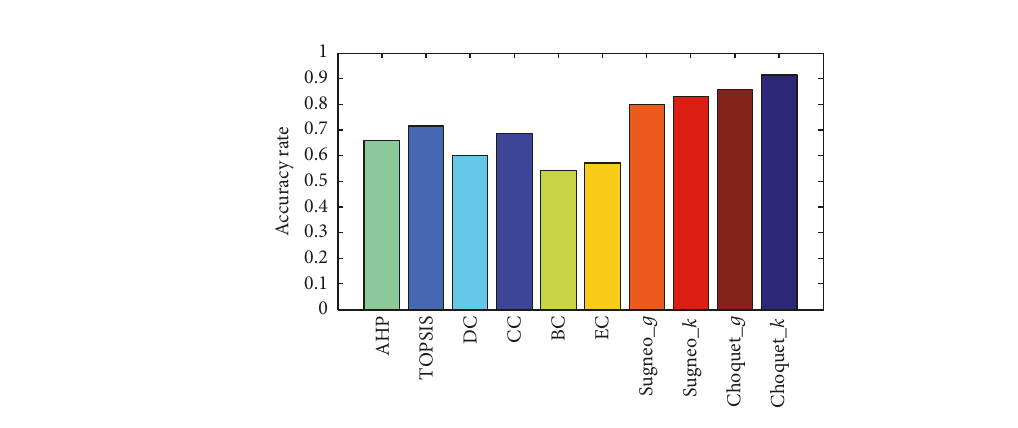
Figure 12: The accuracy rate of these